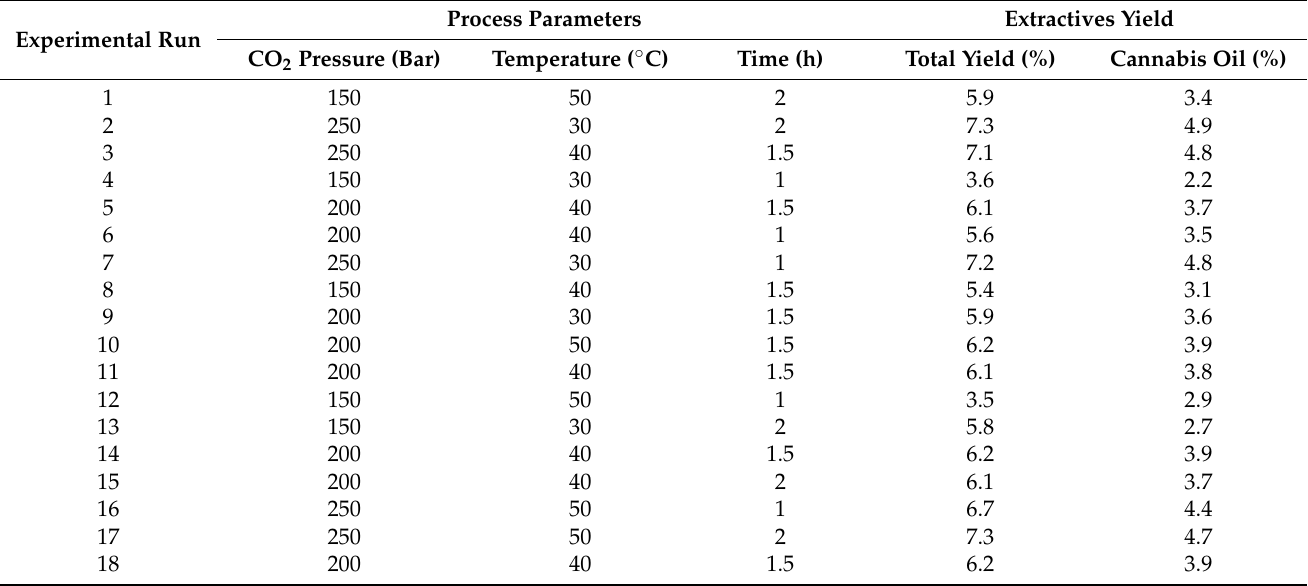
Table 1. Yields of extractives from SCCO 2 extraction of cannabis